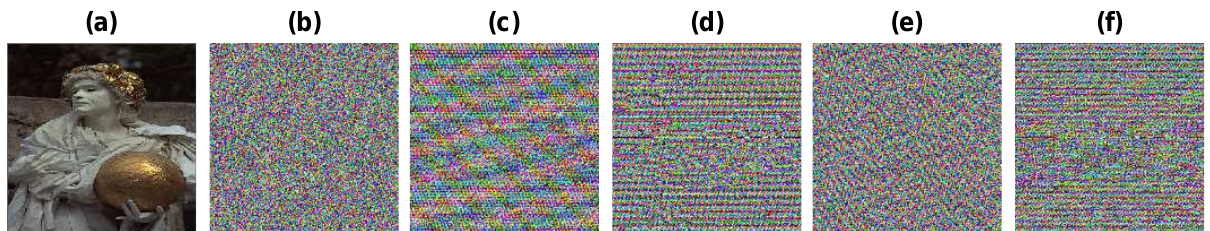
Figure 5. Sensitivity analysis of the image in Figure 2d: ( a ) original image, ( b ) cipher image, ( c – f ) decrypted images with a bit change in the secret key parameters.